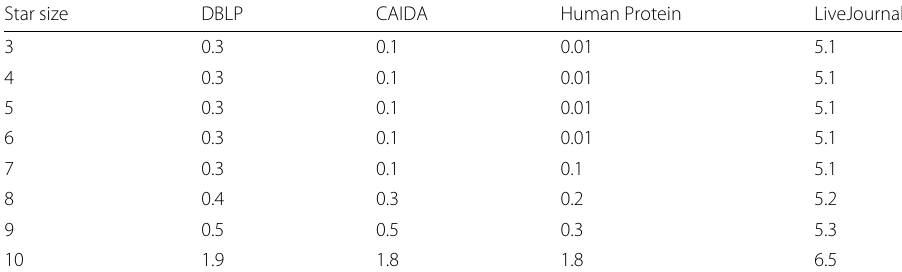
Table 6 Physical memory consumption (GB) of RaME for the computation of the mean of induced counts of star topologies with 3-10 nodes Star size DBLP CAIDA Human Protein LiveJournal